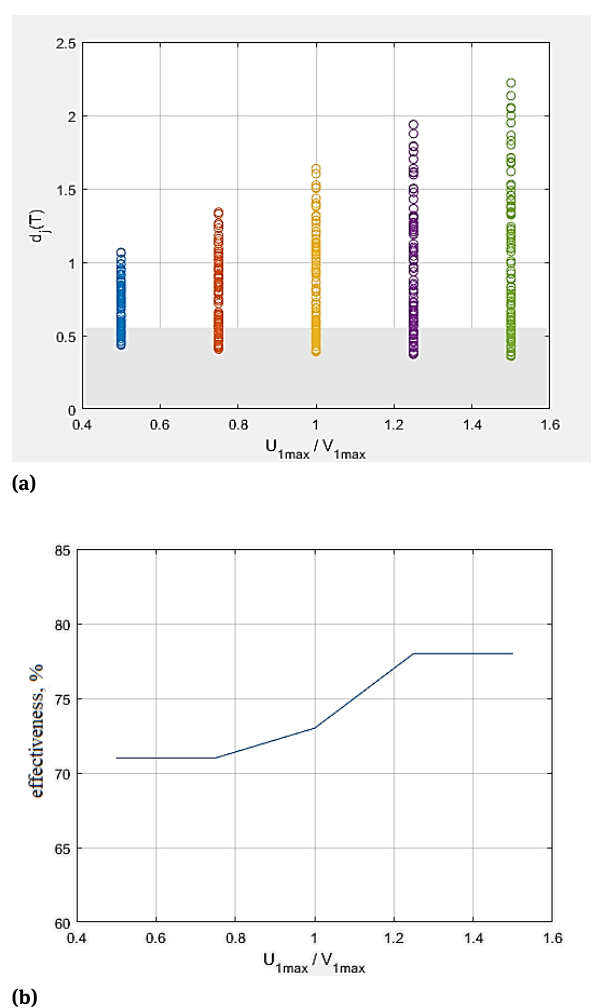
Figure 2: Influence of “throttle response” in UAV compared with the enemy aircraft on the positional advantage achieved by it.